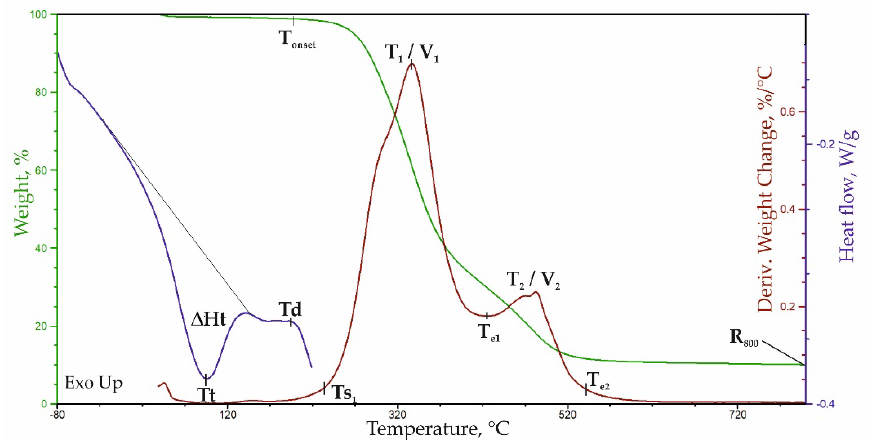
Figure 12. Curves of TG, DTG, and DSC analysis of PU foam.